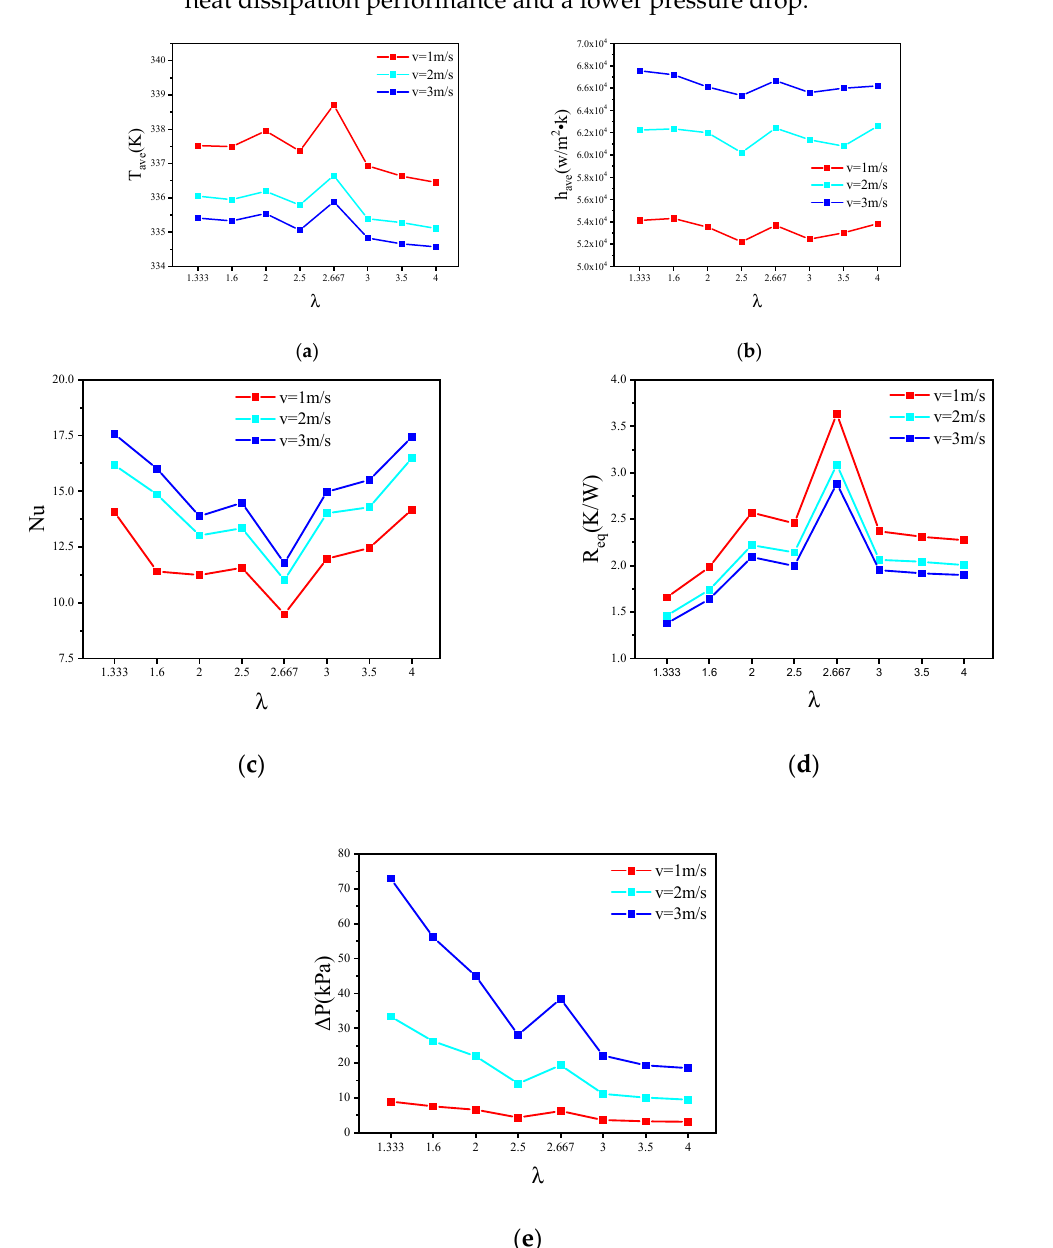
Figure 10. The heat dissipation performance of MC-CR with different aspect ratios. ( a ) The average temperature; ( b ) the average convective heat transfer coefficient; ( c ) Nusselt number; ( d ) the equivalent thermal resistance; ( e ) the pressure drop.